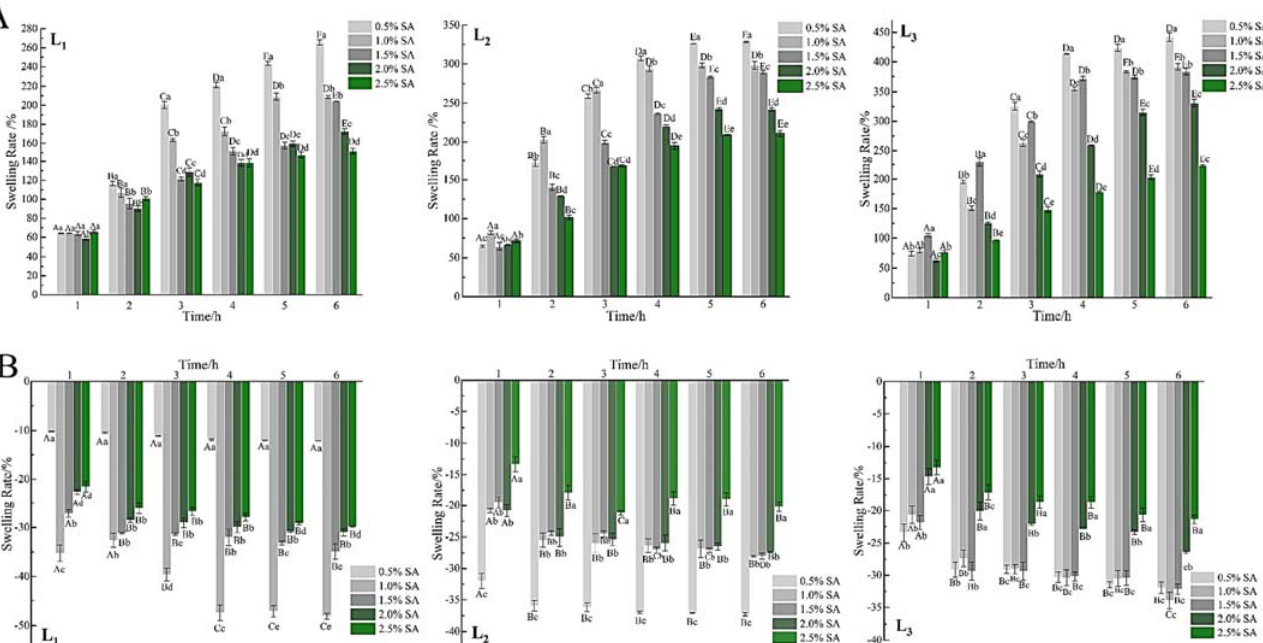
Figure 6. Swelling properties of the gel microspheres in phosphate-buffered solution with a pH of 7.4 ( A ) and 2.0 ( B ). L 1 : the one-layer-gel microspheres; L 2 : the two-layer-gel microspheres; L 3 : the three-layer-gel microspheres. Different lowercase letters indicate significant differences ( p < 0.05) of the swelling degree within the same time period. Different capital letters indicate significant differences ( p < 0.05) of the swelling degree between different time periods at the same pH.